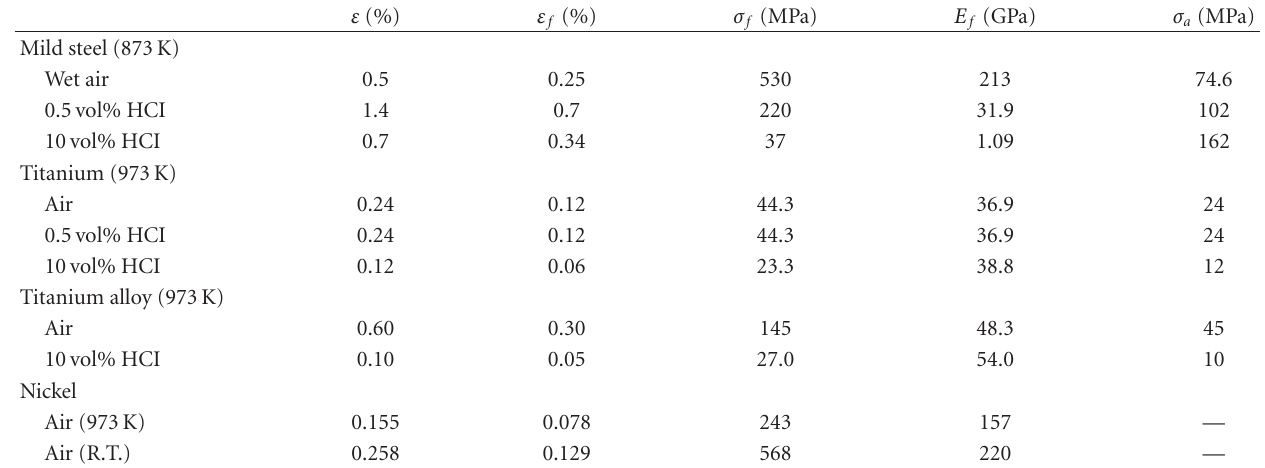
Figure 12: Cracking process of oxide films formed on a Ni specimen by the impact of a glass ball. Table 1: Mechanical properties of oxide films formed on metal